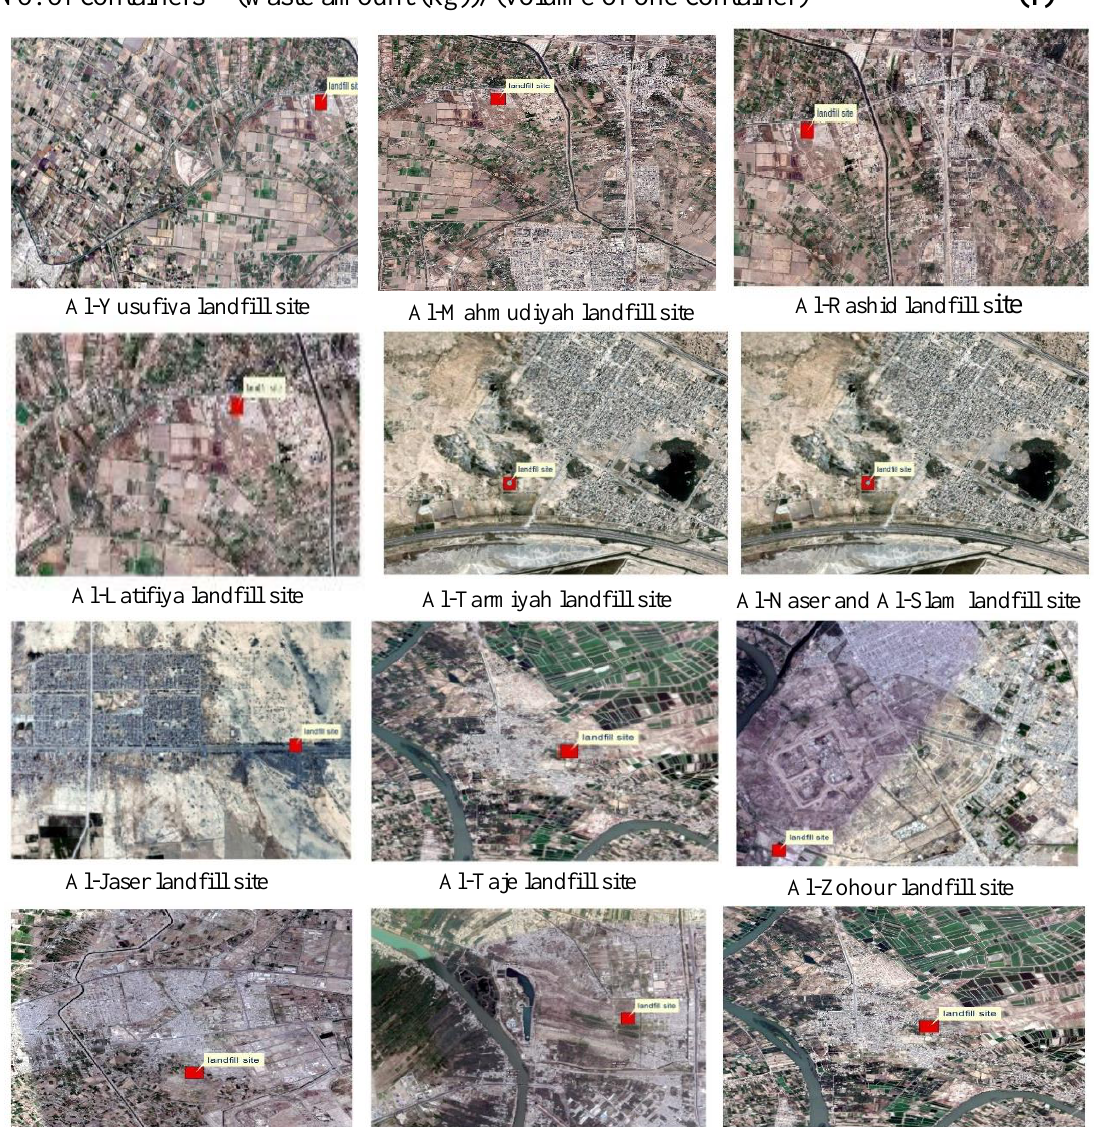
Figure 1: Landfill